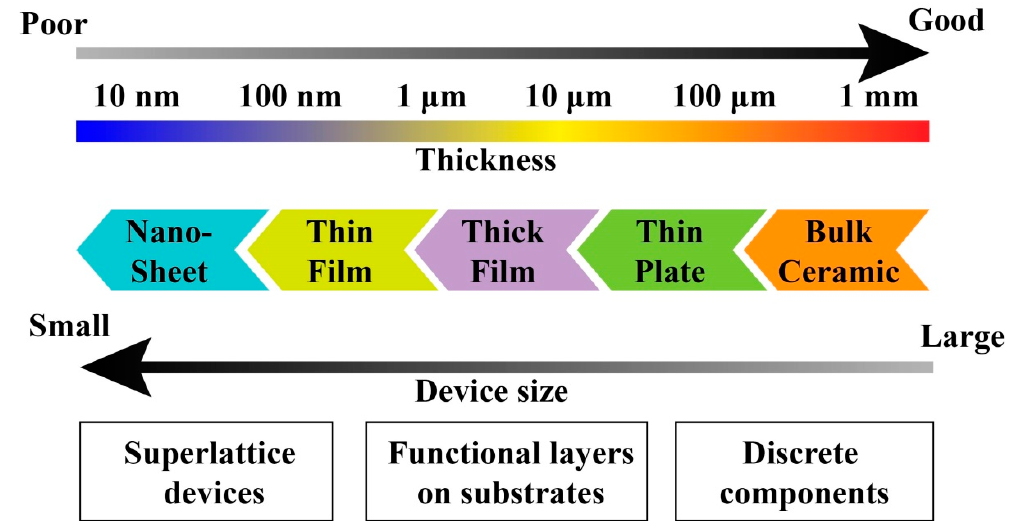
Figure 1. Different applications of piezoelectric thick films with varying thicknesses. Figure 1. Di ff erent applications of piezoelectric thick films with varying